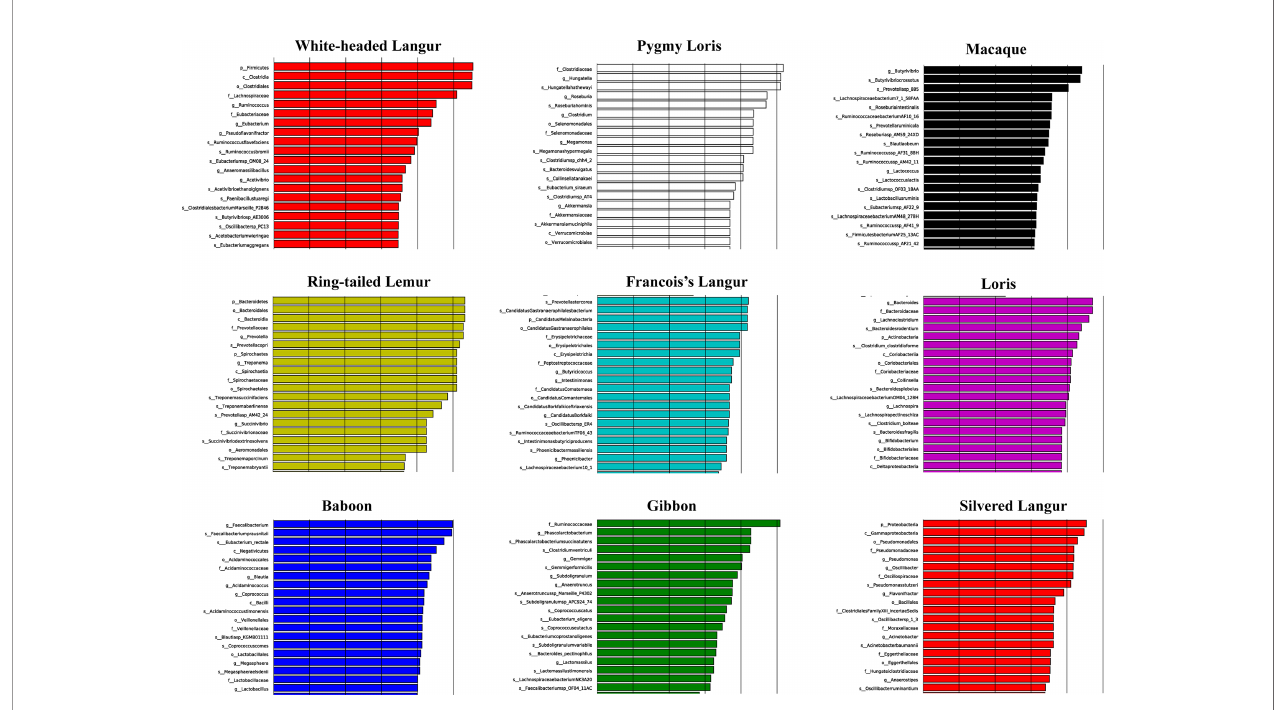
FIGURE 4 | LDA value distribution histogram of the signi fi cantly different biomarkers in all primates. Top 20 are